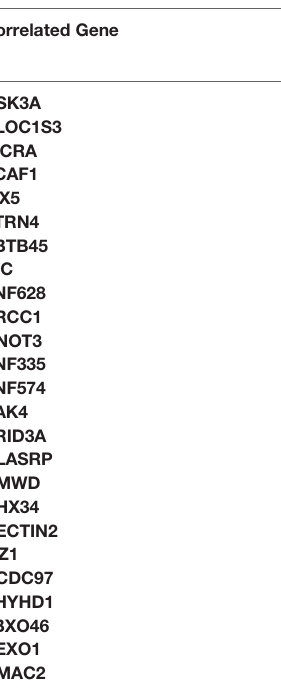
TABLE 3 | Top-ranked co-expressed genes for